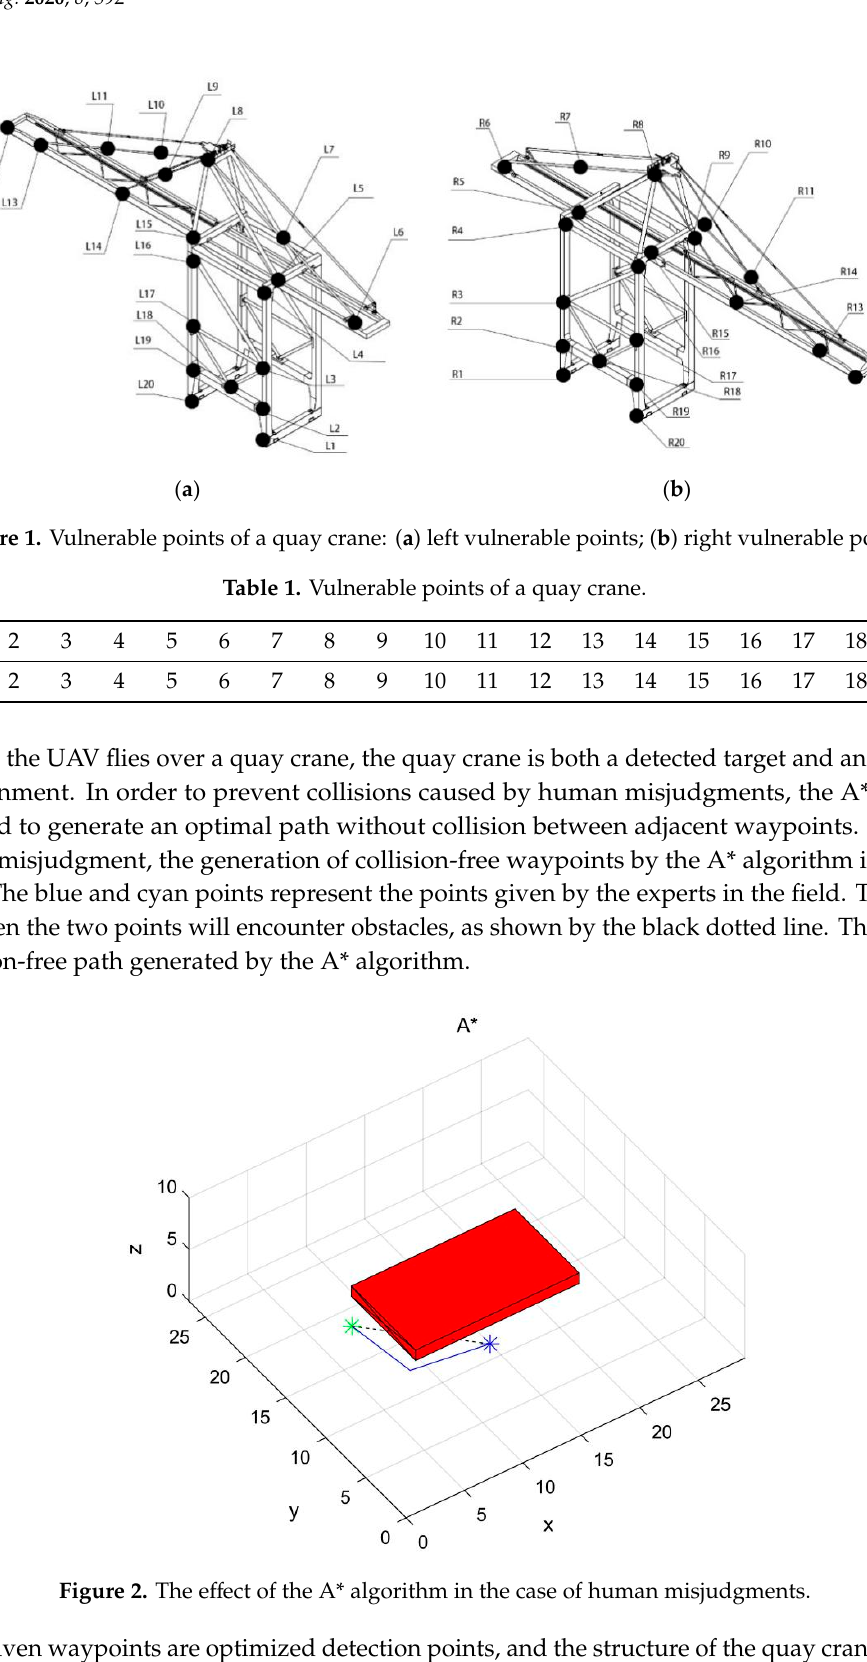
Table 1. Vulnerable points of a quay crane.